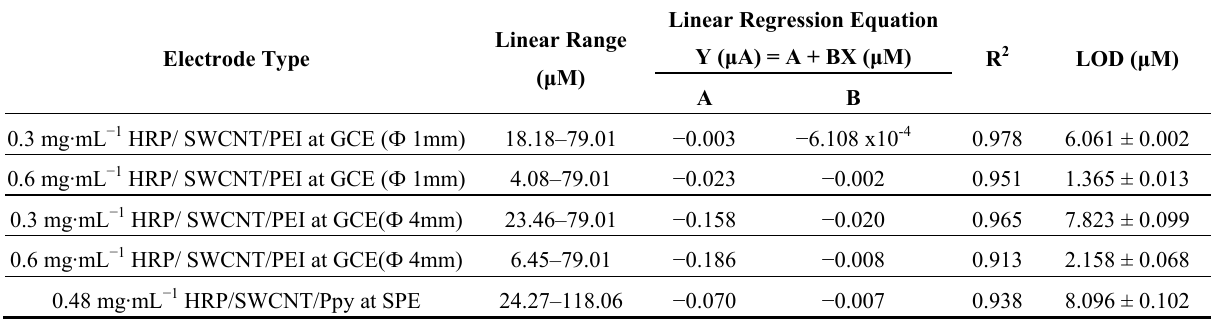
Table 2. Amperometric parameters for acetaminophen